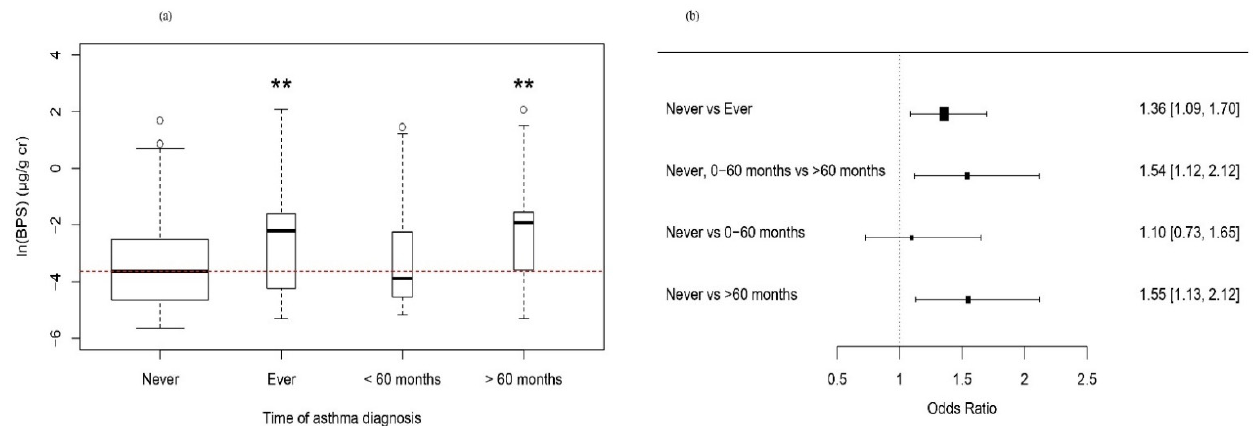
Figure 1. ( a ) Box and whisker plot of urinary bisphenol S and time of asthma diagnosis. Compared to the participants without diagnosed asthma, asthma diagnosed ever group, and asthma diagnosed >60 months of age shows higher median value, and statistically significant in univariate analysis using the Mann–Whitney U test, whereby ** p < 0.01. ( b ) Forest plot shows adjusted odds ratio and 95% confidence interval, which represent the change of odds ratio of categorical dependent variables per 1 unit of the increased/decreased independent variable: ln (urinary bisphenol S ( μ g/g creatinine)). Correlations between the serum IgE and other continuous variables are presented in Table 2. Correlations among BPS, BPA, and BPF were significant in both sexes. Serum IgE levels did not show significant relationships with BPA, BPS, or BPF in either sex. Table 2. Correlation analysis between serum IgE, urinary bisphenol analogues, and possible confounders.